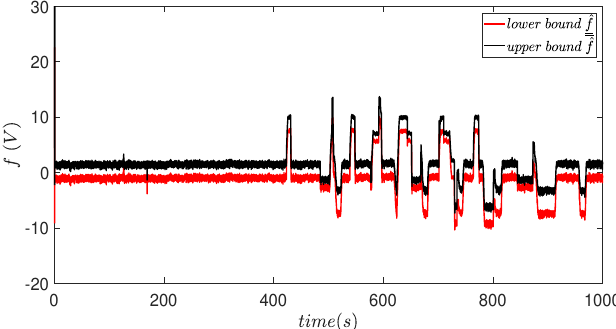
Figure 10. Estimation of the limits of input voltage fault.